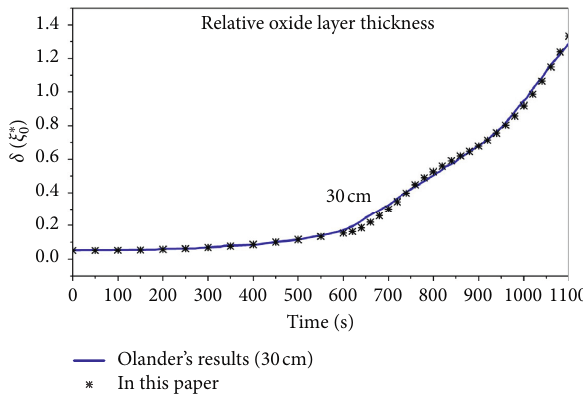
Figure 7: U mass fraction in the melt changes with time at 2100 ° C.